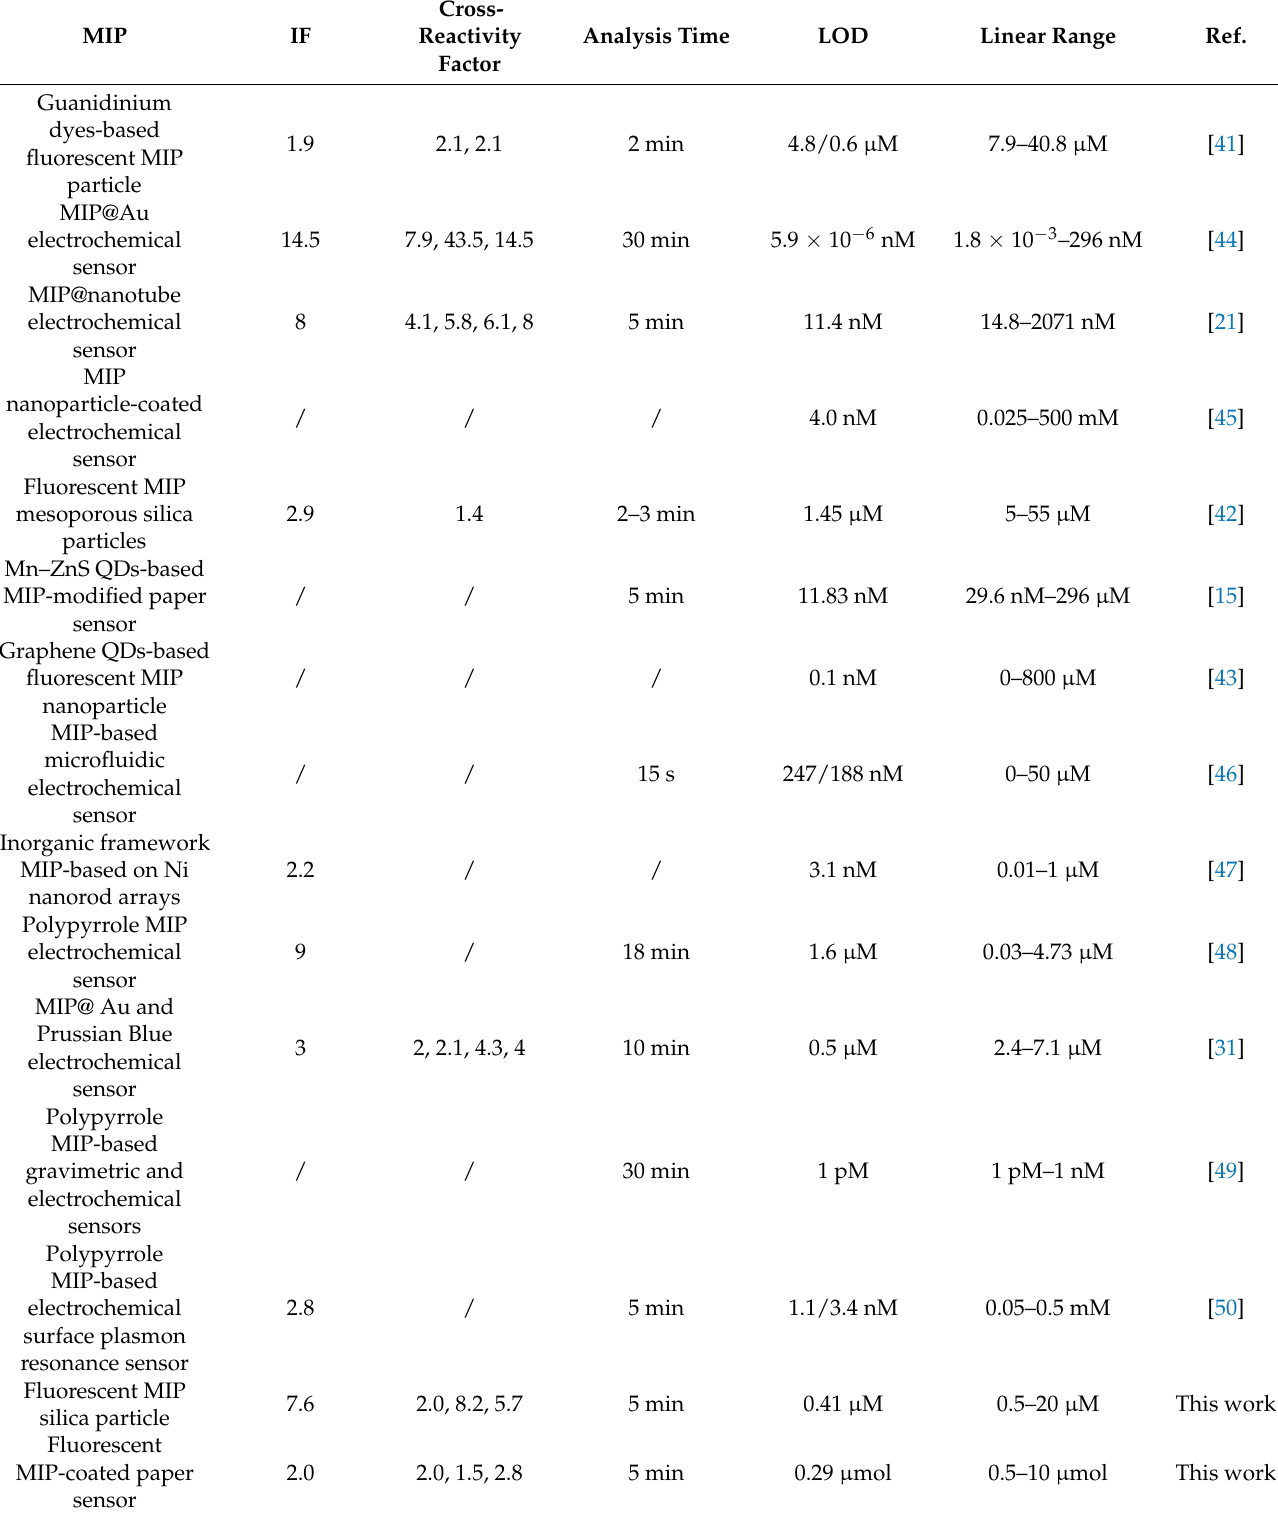
Table 2. Performances of MIPs for sensing glyphosate.